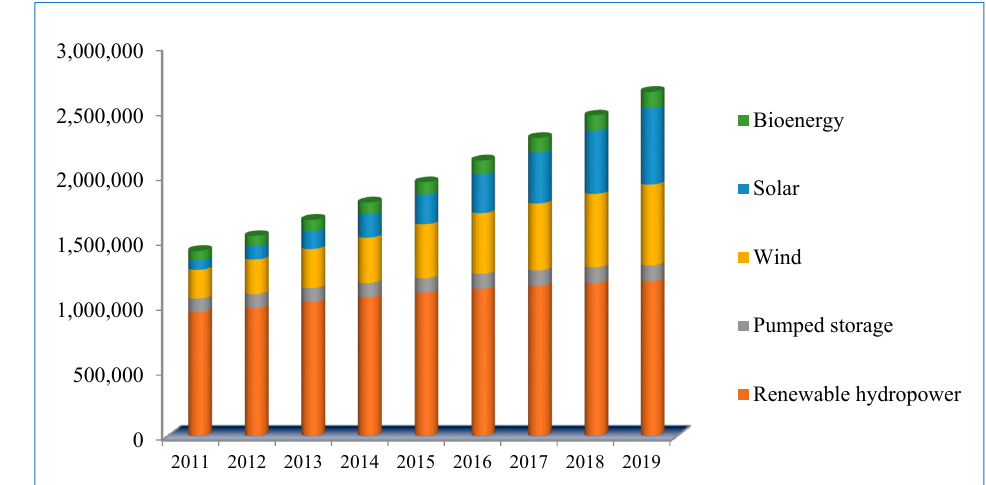
Figure 10. Worldwide renewable electricity capacity (MW) statistics.